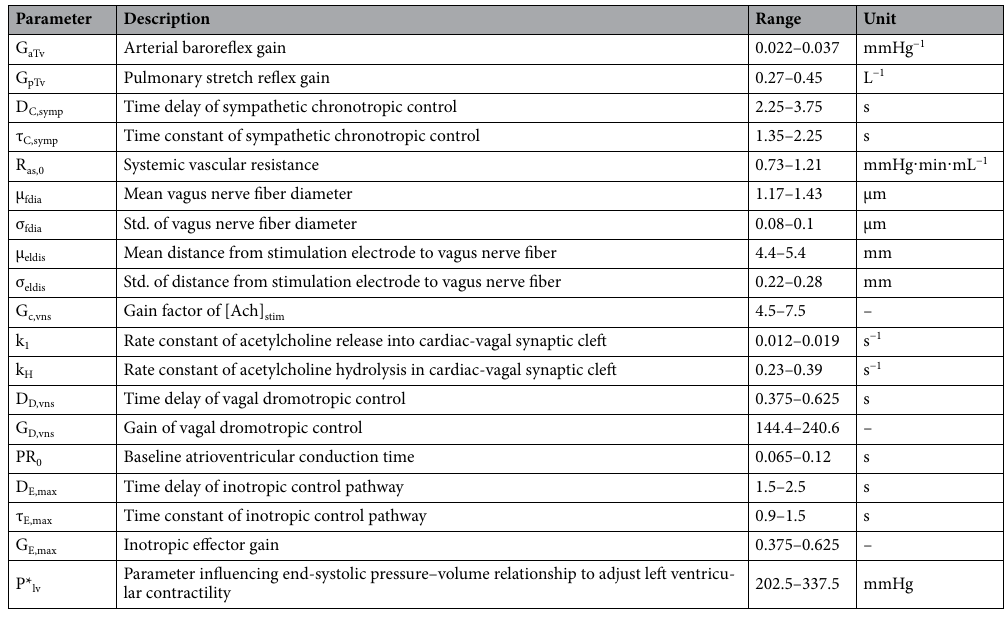
Table 1. Summary of the computational model parameters that were varied to generate the virtual